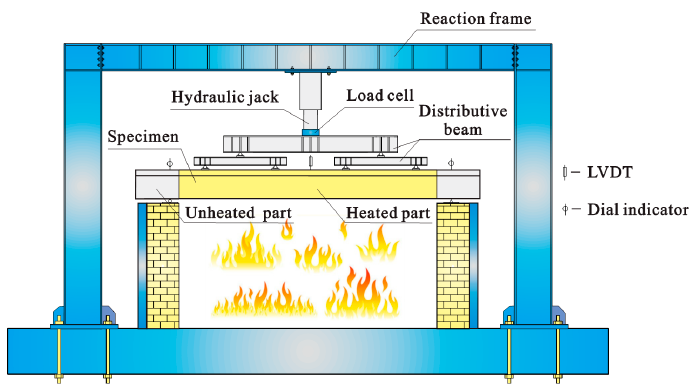
Figure 6. Schematic diagram of the test setup.